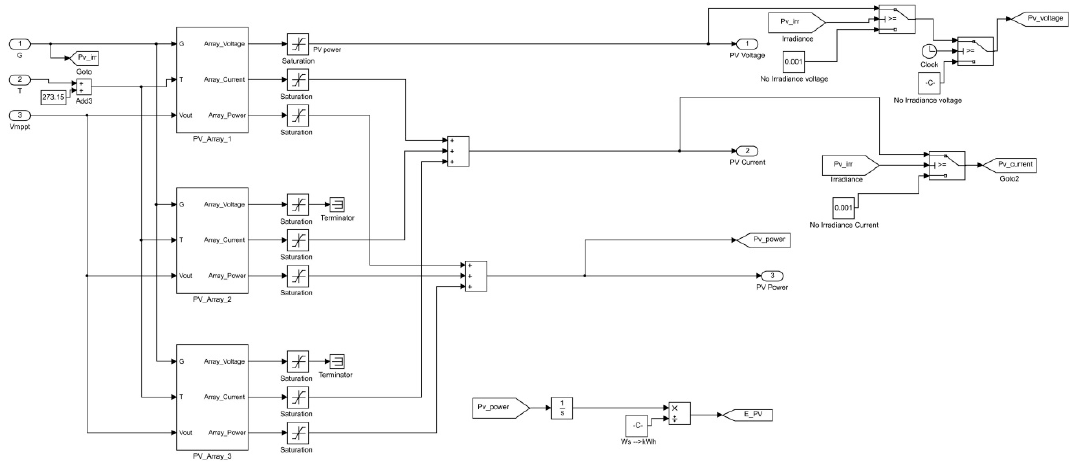
Figure 6. Topology of PV field model in Matlab programming environment.